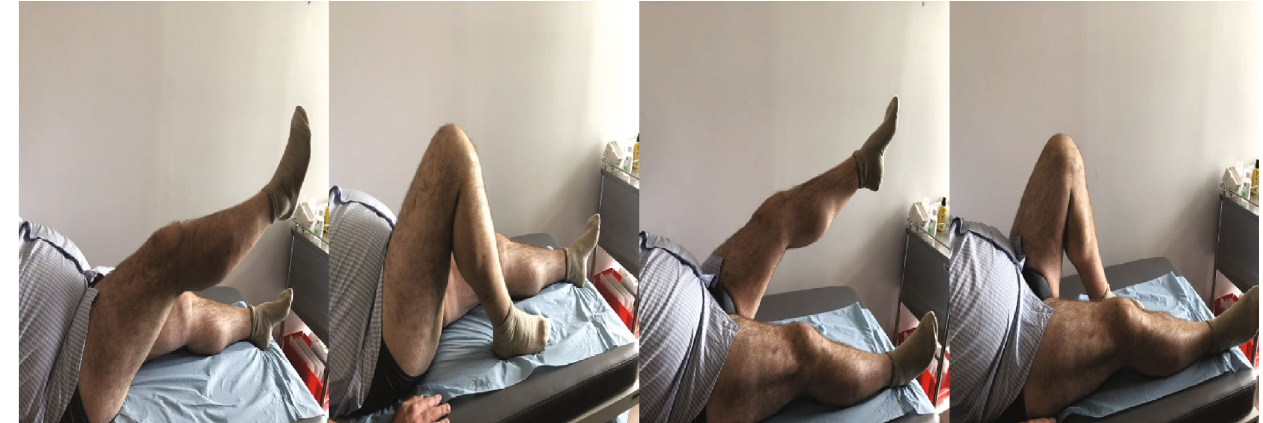
Figure 4: Seven months after surgery: 135 ° fl exion, 0 ° extension at both